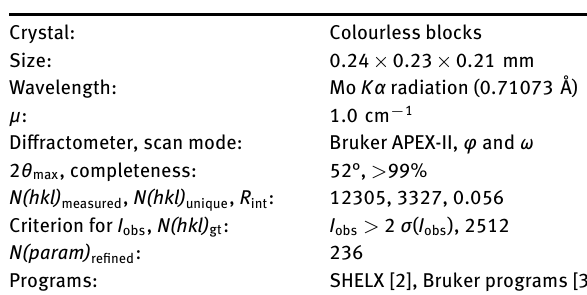
Table 1: Data collection and handling.